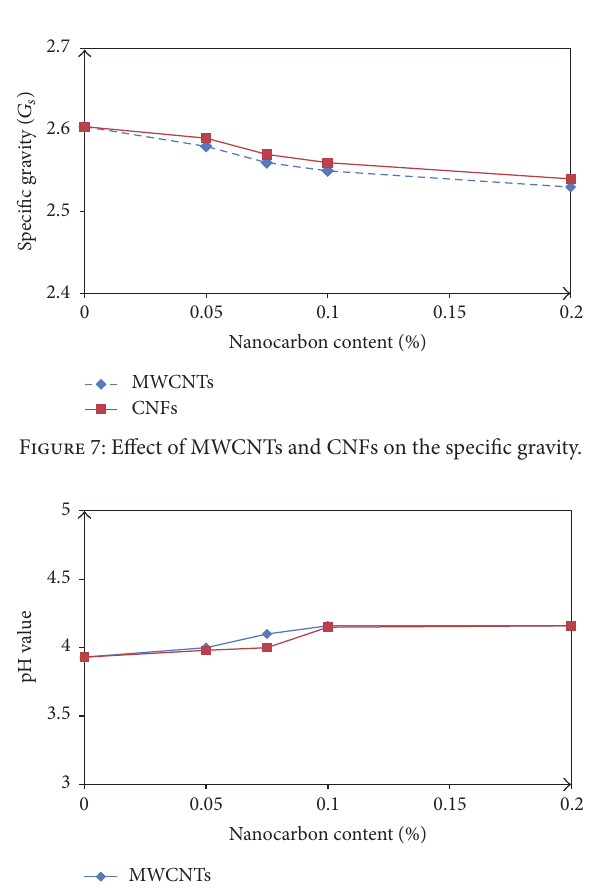
Figure 6: pH meter device used in this research.